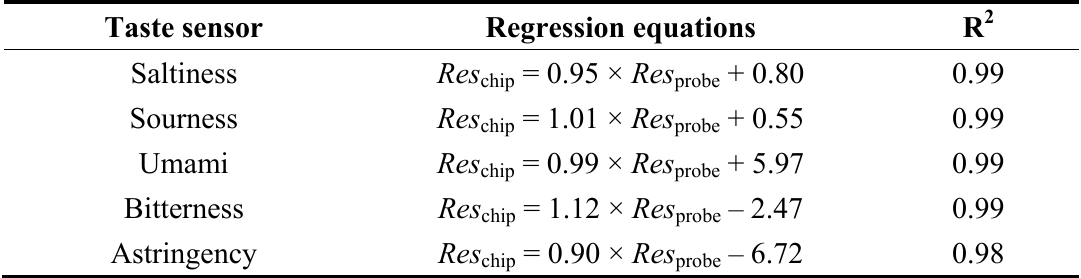
Table 2. Linear regression analysis of the correlation between sensor responses. Res : sensor response of the sensor chips; Res chip